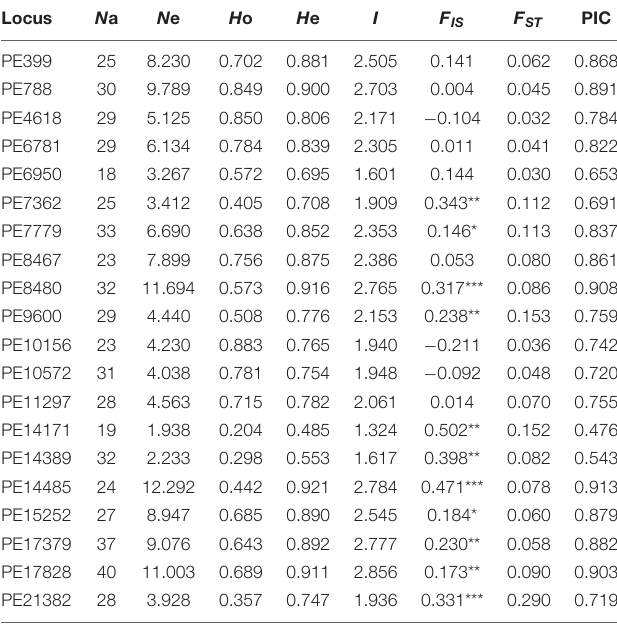
TABLE 1 | Genetic diversity parameters of the 20 EST-SSR makers in all tested individuals of P. emblica.